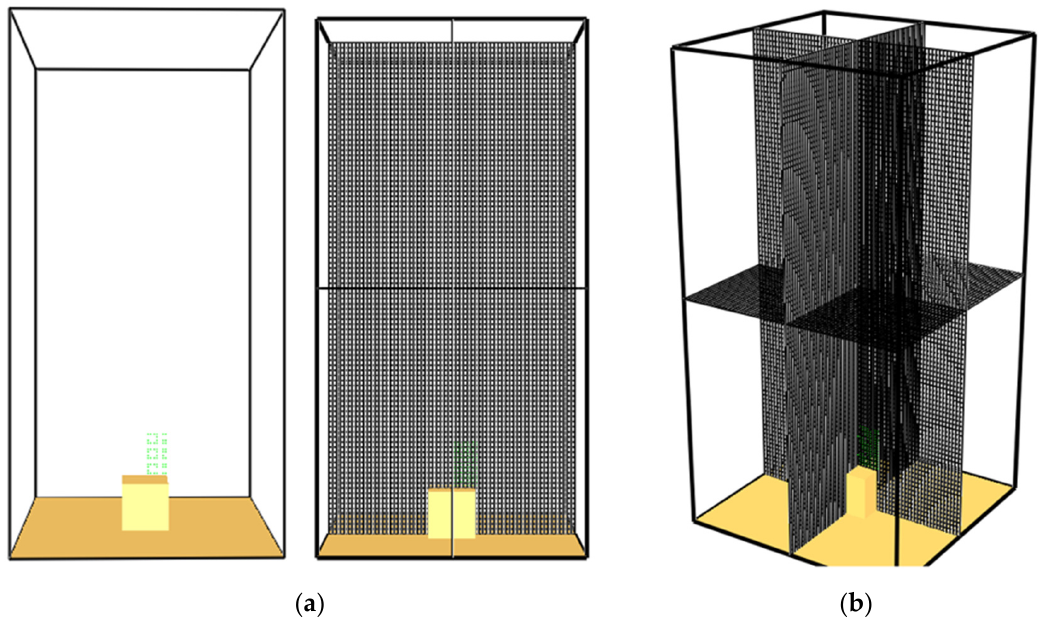
Figure 2. Geometry and mesh for the validation case ( a ) geometry, and ( b ) meshing. Table 1. Grid sizing chose for sensitivity analysis of the validation case. Grid